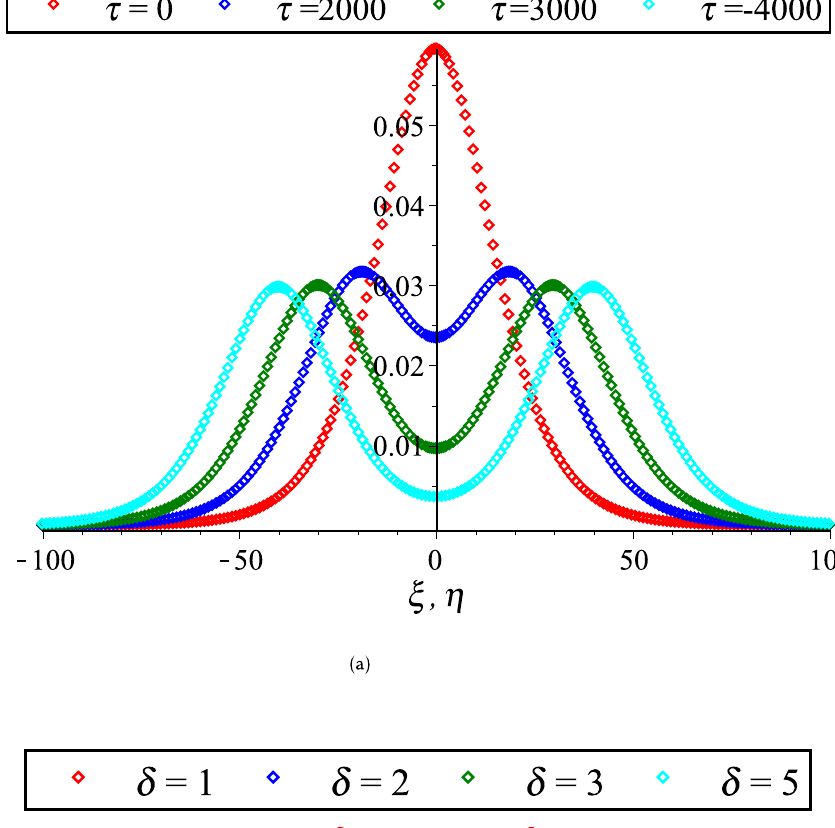
φ ( 1 ) = φ ( 1 ) l + φ ( 1 ) r for different values of ( a ) τ ( δ = 1) and ( b ) δ ( τ = 2500). The (cid:31) (cid:30)